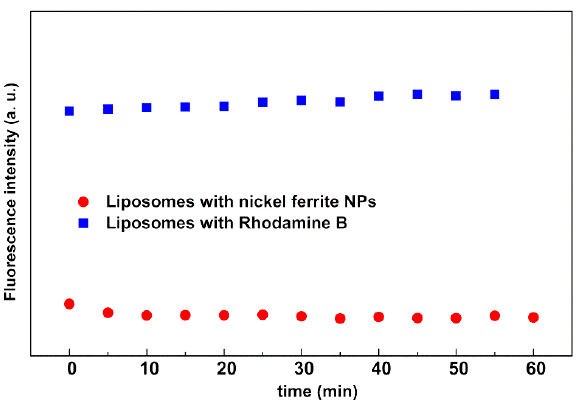
Figure 12. Fluorescence intensity as a function of time of irradiated liposomes containing nickel ferrite NPs (without gold) and liposomes containing only Rhodamine B-DOPE (without any NPs). Considering, as an approximation, that the fluorescence quantum yield of Rhodamine B near the nanoparticles was much lower than the quenching ratio, 𝐼 F0 /𝐼 F (that is always higher than 1), the dependence of the fluorescence intensity ( 𝐼 F ) on temperature can be expressed as Equation (1) (detailed explanation in Supplementary Materials).